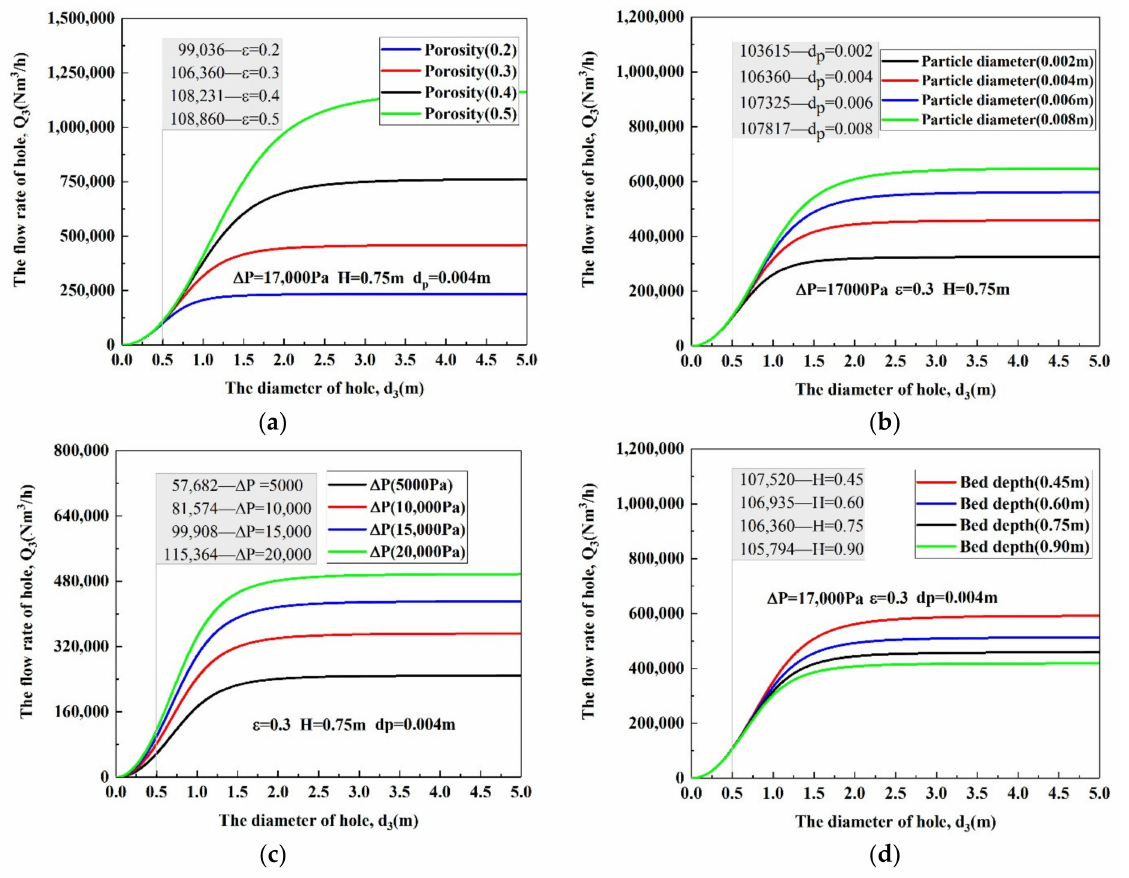
Figure 8. The variation in air leakage flow rate as a function of hole diameter under different process conditions: ( a ) bed porosity; ( b ) particle diameters; ( c ) initial negative pressure; ( d ) bed